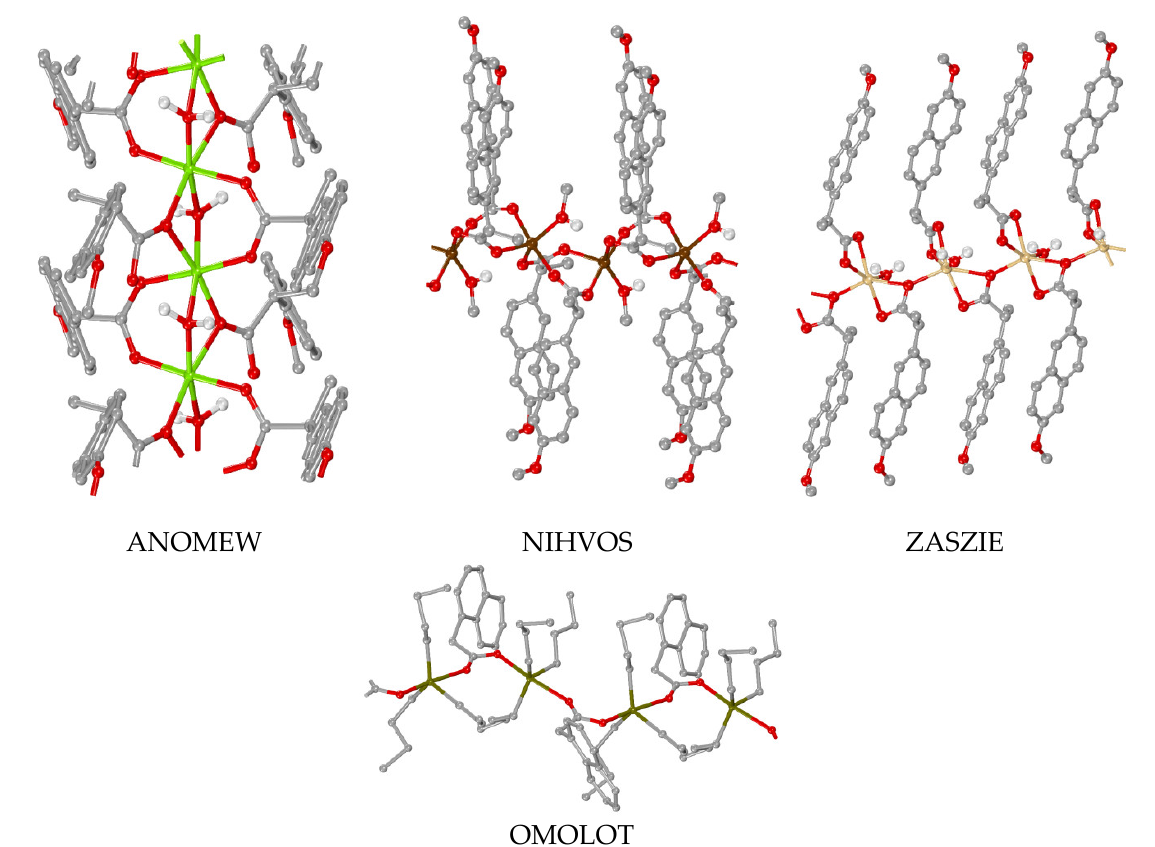
Figure 22. Molecular structures of selected complexes of Table 4 bearing 1–naphthylacetato and naproxen ligands as bridging ligands. ANOMEW = [Mg(µ 2 –NAP–O,O)(µ 2 –NAP–O,O′)(µ 2 –H 2 O)] n [41]; NIHVOS = [Mn(µ 2 –NAP–O,O′) 2 (CH 3 OH)] n [90]; ZASZIE = [Cd(NAP–O,O′)(µ 2 –NAP–O,O,O′)(H 2 O)] n [46] and OMOLOT = [( n –Bu) 3 Sn(µ 2 –N1A–O,O,O′)] n [88]. Color code for atoms: C: gray, O: red, Mg: light green, Mn: brown; Cd: yellow and Sn: dark yellow. The figures of the structures were adapted from the corresponding references.